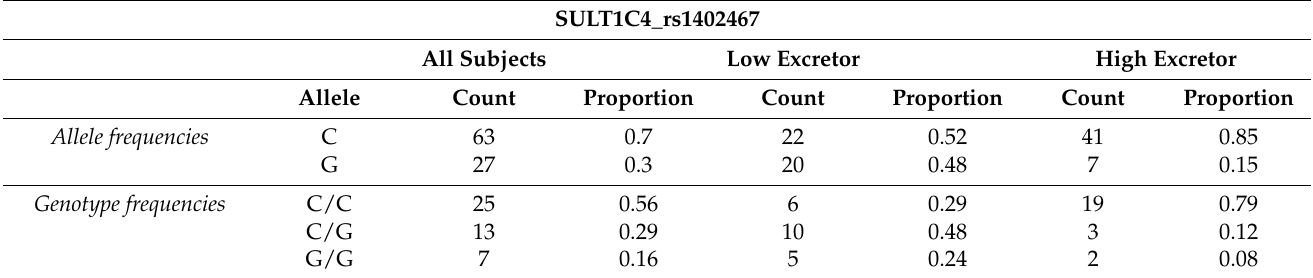
Table 10. Analysis of association of SULT1A1_ rs1402467 polymorphism with the excretion of phase II flavanone metabolites in urine of studied volunteers after single dose of orange